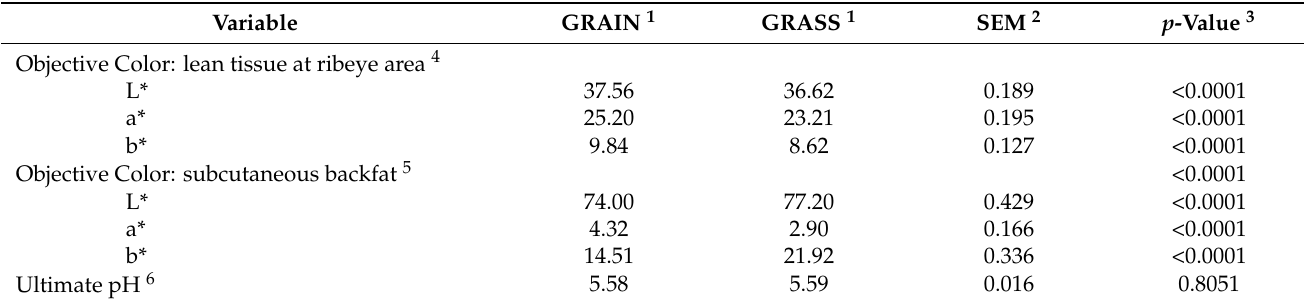
Table 2. Least squares means for effect of finishing system on objective color measurements and ultimate pH of grain- or grass-finished bison